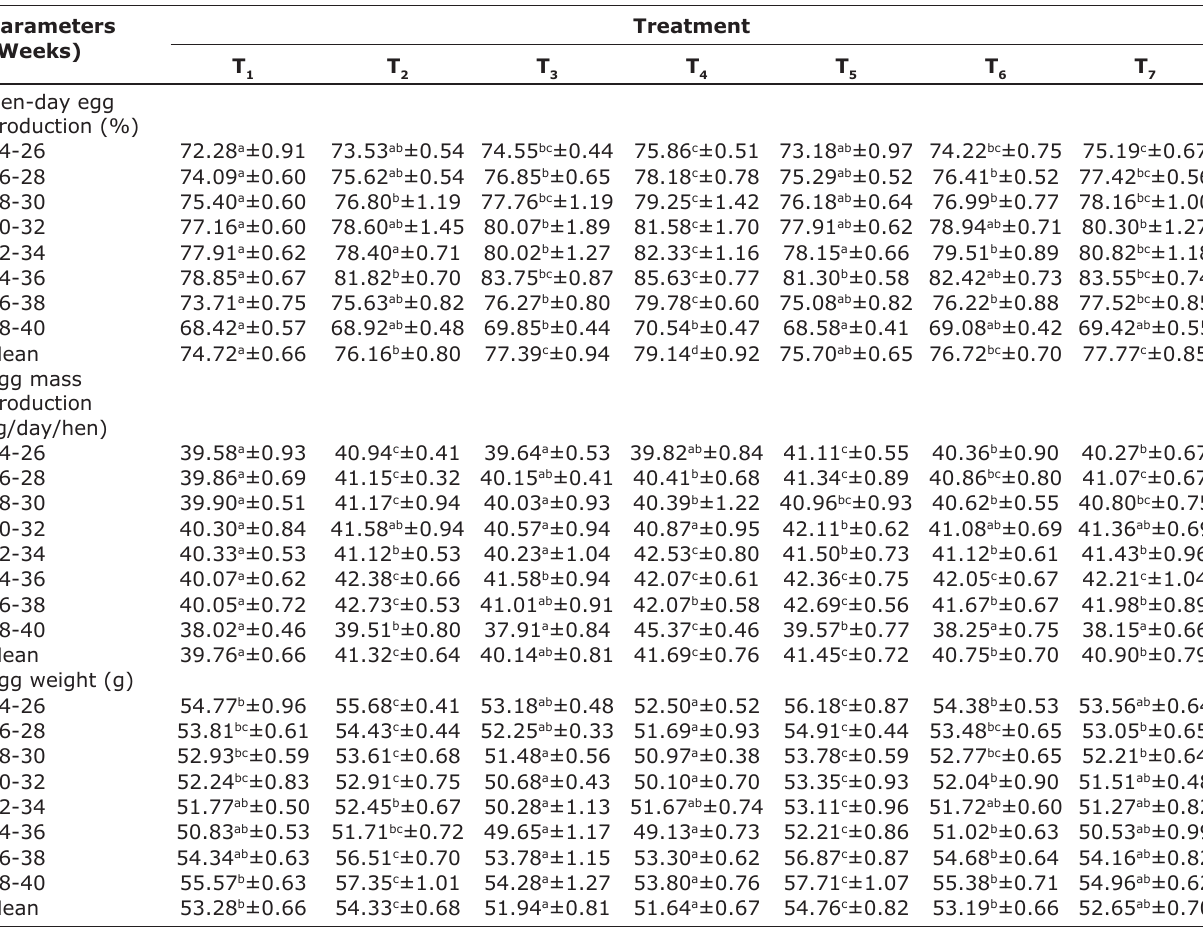
Table-3: Egg production and egg weight in layers fed diet supplemented with different levels of probiotics and prebiotics during progressive weeks of age. Parameters (Weeks)